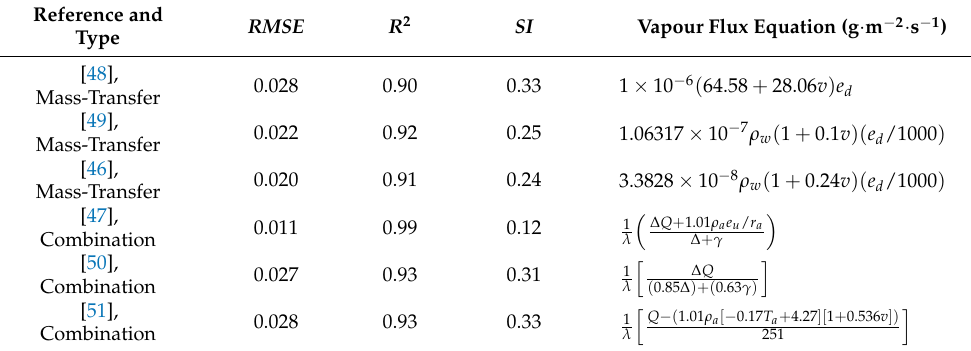
Note. Equations are adapted for appropriate units, as provided in Tables 2 and 3. RMSE is root mean square error, R 2 is correlation coefficient, and SI is scatter